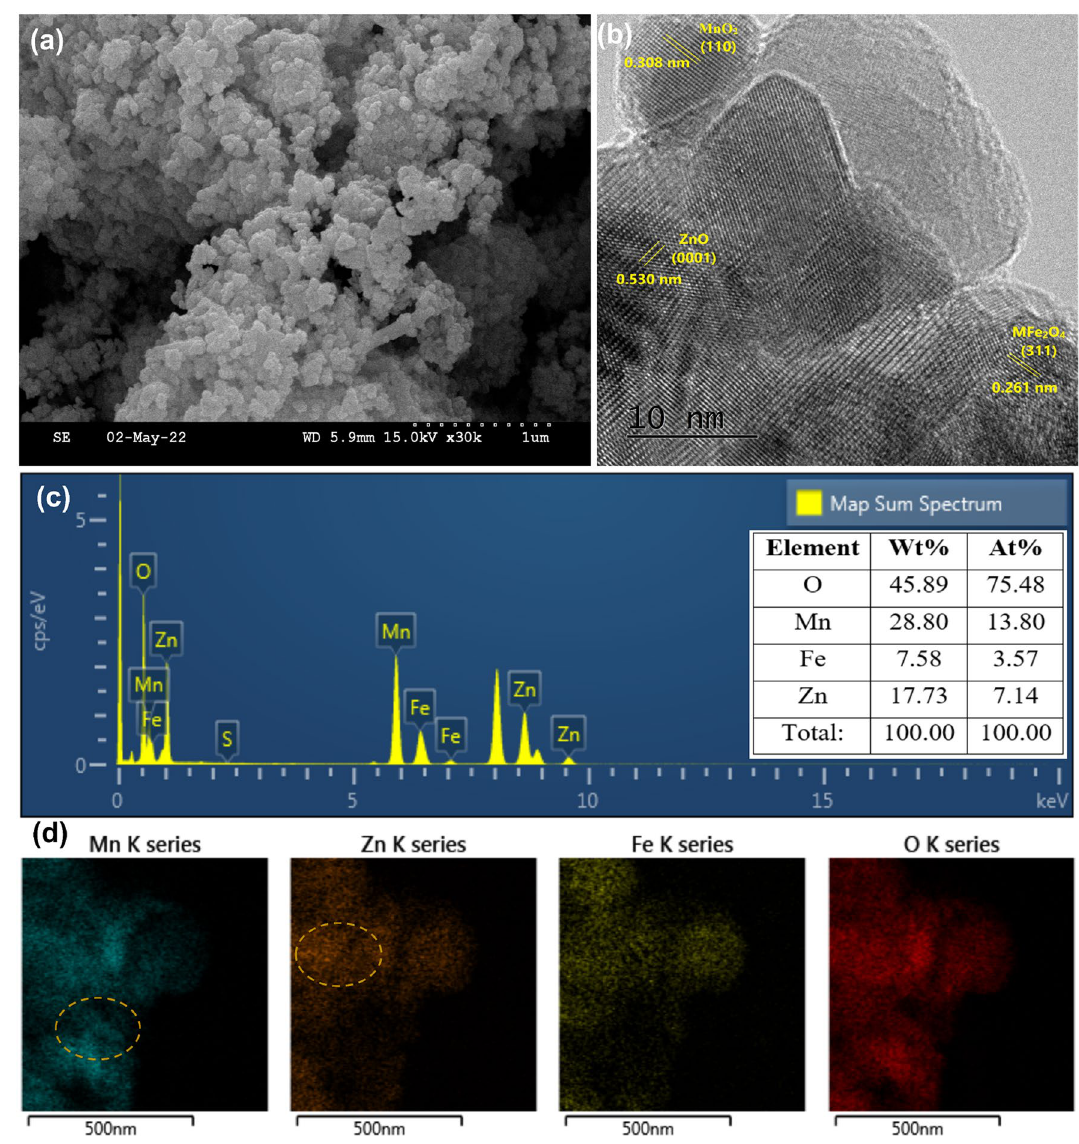
Figure 1. ( a ) SEM micrograph; ( b ) high-resolution TEM micrograph; ( c ) elemental distribution analysis; ( d ) 2D elemental mapping of The PXRD pattern of MFZO nanocomposite has diffraction peaks for β-MnO 2 (purple circle) 23 , ZnO (pink circle) 24 , ferrites (green square) 25 , and NaNO 3 (blue square) 26 , which confirmed a poly-oxide nature of the com- posite (Fig. 2a). A similar report is available for the fabrication of Cu–Zn-Mn ternary oxide nanocomposite, where CuO, ZnO, and MnO 2 nanoparticles were confirmed 18 . The absence of a washing step during the MFZO fabrication was responsible for the presence of NaNO 3 in the sample. The N 2 adsorption–desorption isotherm of MFZO nanocomposite exhibited a Type III behaviour, generally expected in macro-porous materials (Fig. 2b) 23 . The nanocomposite possessed a BET surface area of 21.03 m 2 g −1 and a pore volume of 0.07 cm 3 g −1 . These val- ues are higher than other nanocomposites like Mn 2 O 3 /Fe 2 O 3 (6.18 m 2 g −1 , 0.12 cm 3 g −1 ) 27 , CeO 2 /Mn 2 O 3 /Fe 2 O 3 (15.64 m 2 g −1 , 0.09 cm 3 g −1 ) 28 , and Fe 2 O 3 /Na 2 SO 4 (2.89 m 2 g −1 , 0.01 cm 3 g −1 ) 29 used for the same applications. The spectrum has a broad band centred at 621 cm −1 for the metal–oxygen stretching vibrations 30,31 . The bands at 835 and 1385 cm −1 were attributed to the asymmetric stretching vibration ( ν 3 -NO 3 − ) and out-of-plane bending vibration ( ν 2 -NO 3− ), respectively, of nitrate 32 . The bands at 3433 and 1635 cm −1 were assigned to the stretching and bending vibration modes of adsorbed water molecules, respectively (Fig. 2c) 33 . The XPS survey of MFZO confirmed peaks for Na 1 s, Zn 2p, Fe 2p, Mn 2p, O 1 s, and N 1 s at their respective binding energy. The Na 1 s and N 1 s peaks were associated with the presence of NaNO 3 (Fig. 2d). The HRXPS Mn 2p 3/2 signal of MFZO deconvoluted into three contributions at 640.7, 641.6, and 642.8 eV for Mn 2+ (23.2%), Mn 3+ (43.9%), and Mn 4+ (32.9%) oxidation states of Mn ions, respectively 34 . The analyses showed that multivalent Mn ions were related to the formation of MnO 2 and Mn-based ferrites (Fig. 3a, Table S1). The HRXPS Zn 2p spectrum has two peaks at 1021.4 and 1044.3 eV for 2p 3/2 and 2p 1/2 signals of Zn 2+ ions,